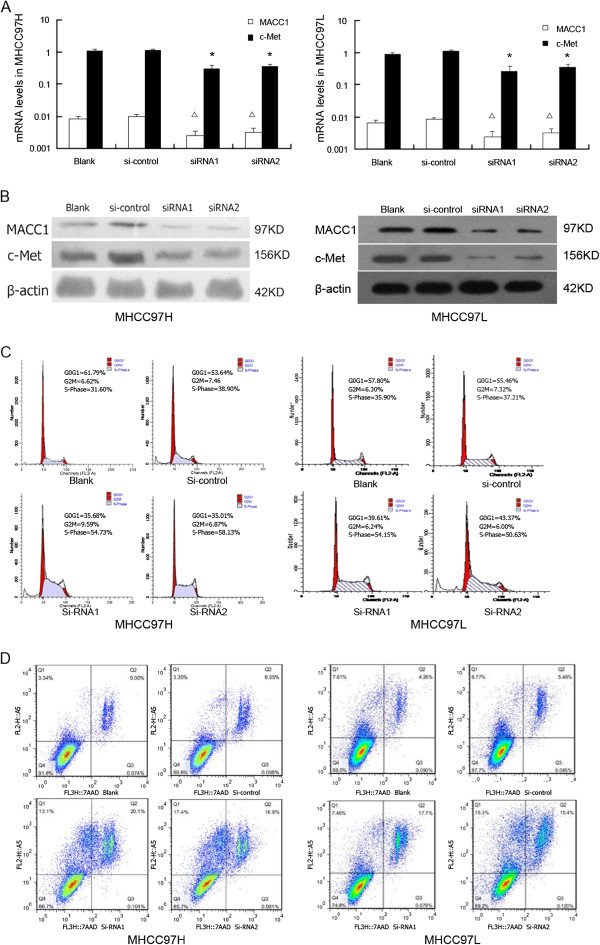
MACC1 and c-Met expression associated with tumor cell cycle and apoptosis. A. Comparison of MACC1 and c-Met mRNA levels in MHCC-97H and MHCC-97 L cell lines transfected with two pairs of MACC1-si RNA and control-si RNA, as determined by real-time RT-PCR (Δp < 0.05 versus blank or si-control, *p < 0.05 versus blank or si-control). B. MACC1 and c-Met protein expression in MHCC-97H and MHCC-97 L cell lines transfected with two pairs of MACC1-si RNA and control-si RNA, as determined by Western Blot. C: The cell cycle analysis in MHCC-97H and MHCC-97 L cell lines transfected with MACC1-siRNA by Flow cytometric analysis. D: The percentage of apoptotic cells in MHCC-97H and MHCC-97 L cell lines transfected with MACC1-si RNA by Flow cytometric analysis.